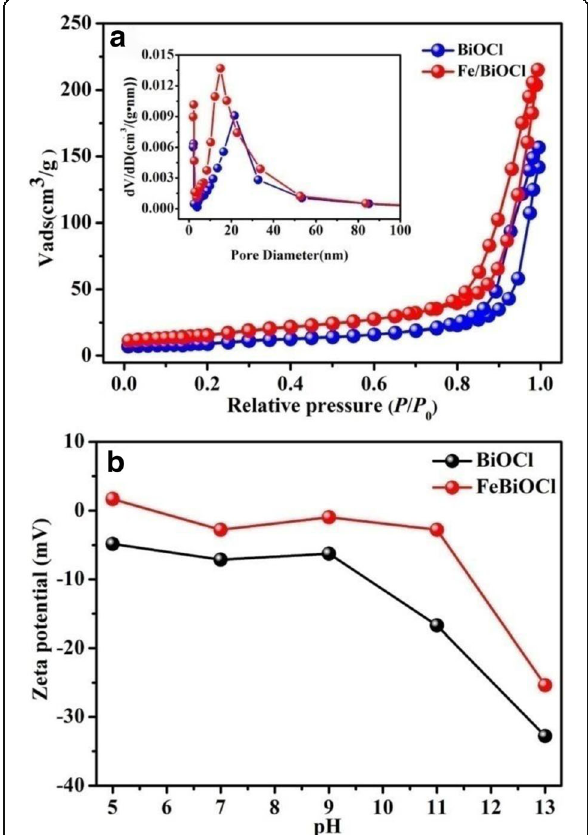
Fig. 6 N 2 adsorption-desorption isotherms as well as pore size distribution curves (insert) ( a ) and zeta potentials ( b ) of BiOCl and Fe/BiOCl (0.25)